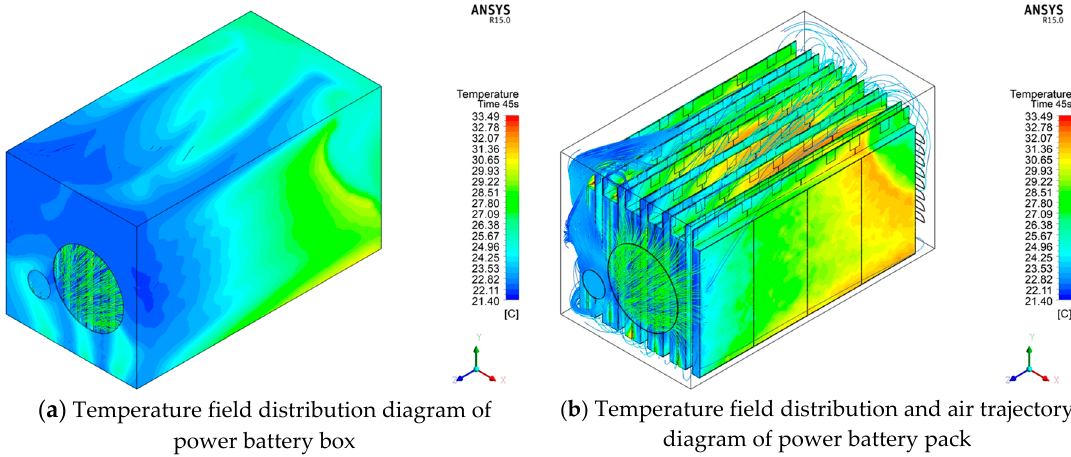
Figure 3. Distribution diagram of short-term high-current limit discharge condition (45 s).